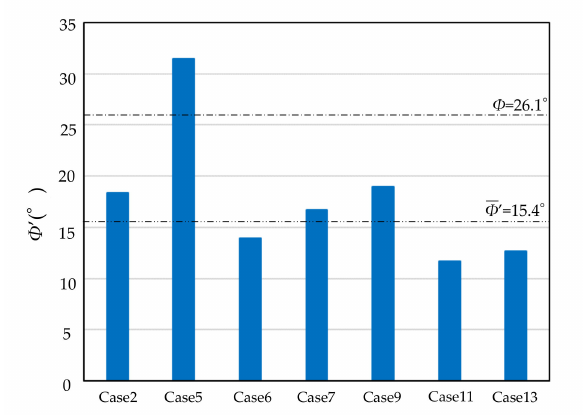
Figure 26. Slope angle of local scour hole ( N = 10,